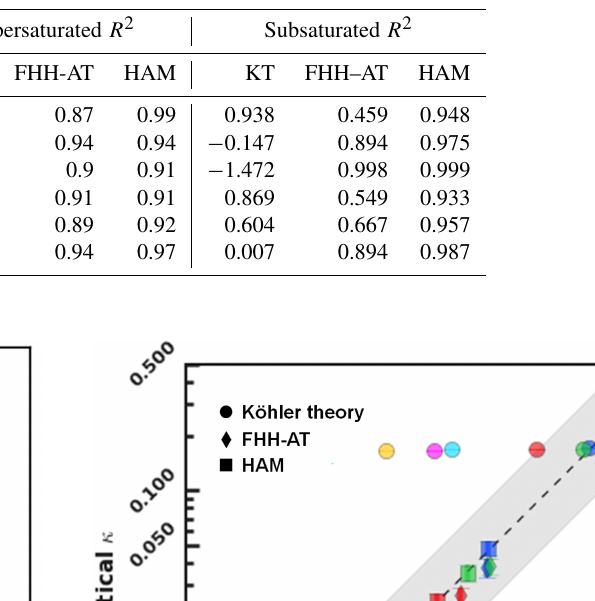
Table 3. Goodness of fit ( R 2 ) scores for model fits applied to supersaturated and subsaturated measurements of pure and internally mixed samples.